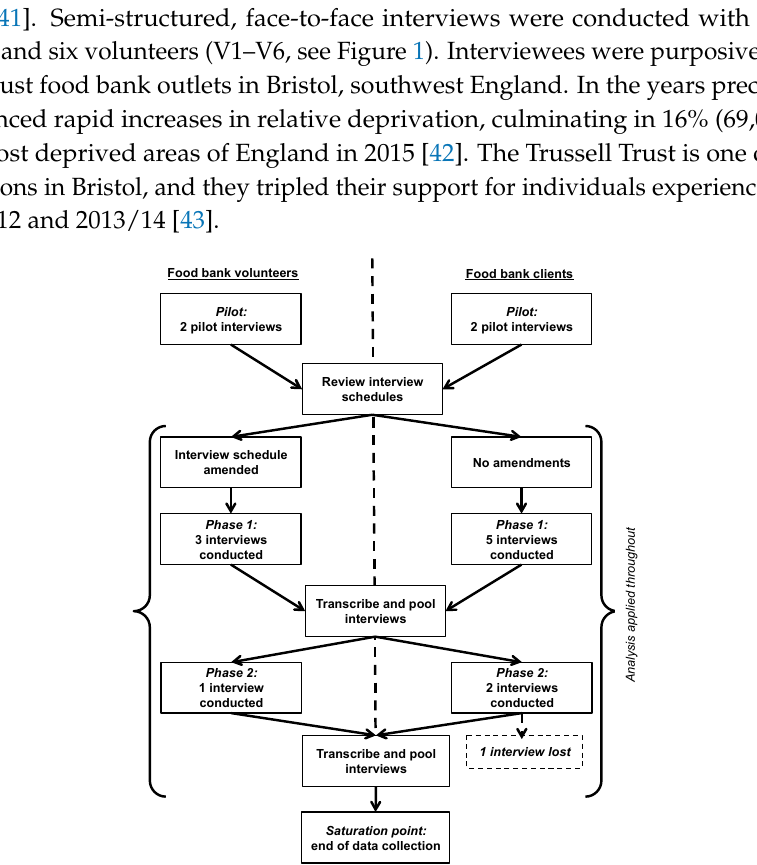
Figure 1. Flowchart of data collection and analysis.